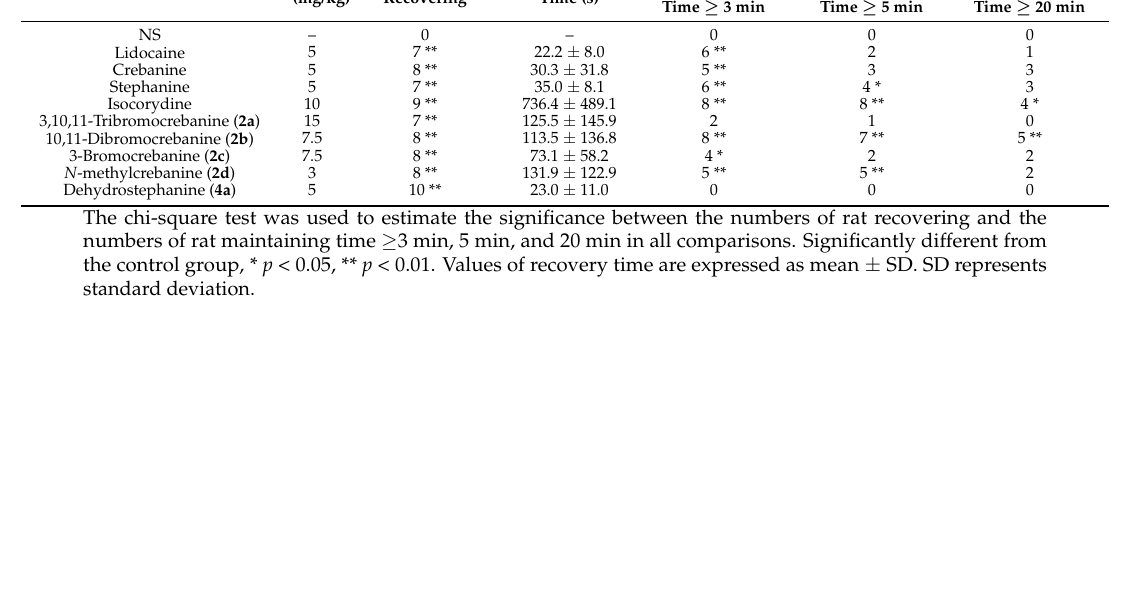
Table 1. Antiarrhythmic activity of fiveaporphine derivatives ( 2a – d and 4a ) in the model of arrhythmia, induced by BaCl 2 in anesthetized SD rats (iv) ( n = 10).